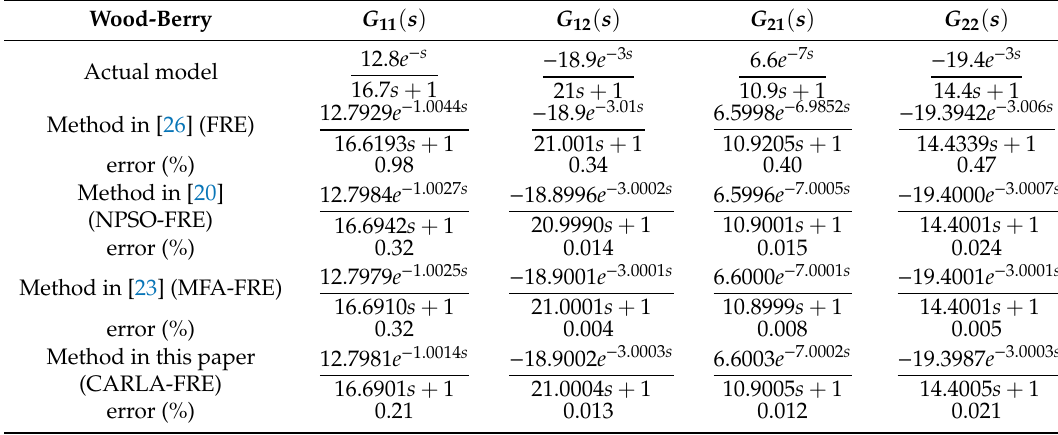
Table 3. Wood-Berry model identification results. (FRE: frequency response estimation; NPSO-FRE: NLG-particle swarm optimization-FRE; MFA-FRE: modified fireworks explosion optimization algorithm-FRE).